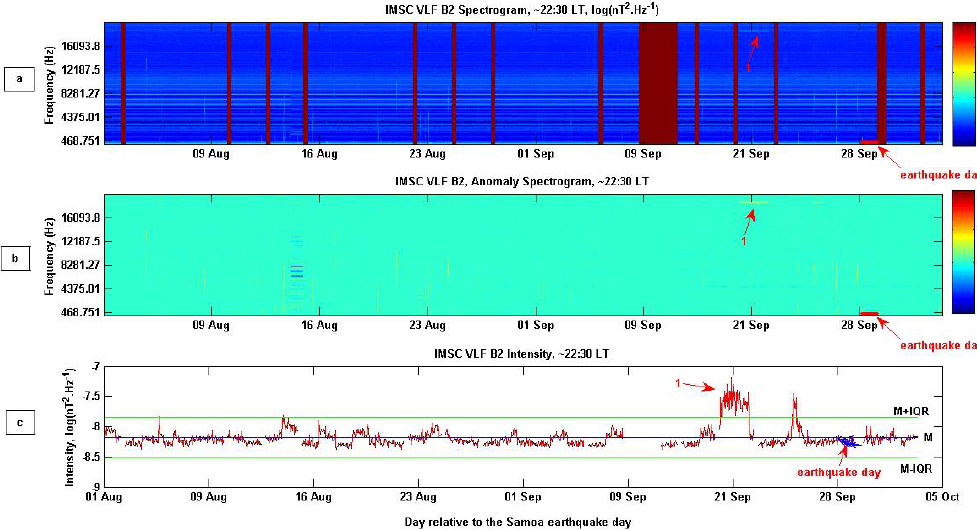
Fig. 3. Same as Fig. 2 but for IMSC VLF spectrogram of the B2 magnetic component.